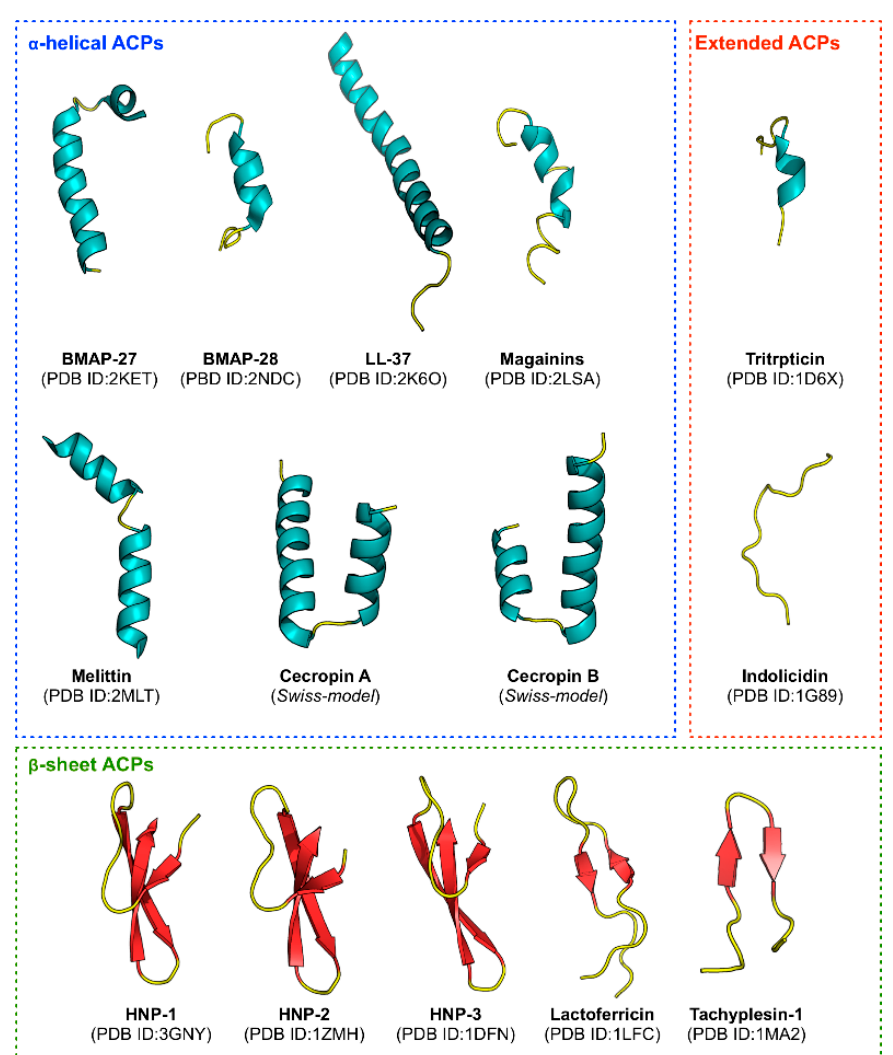
Figure 1. Overview of the structural diversity of three classes of anticancer peptides. Each structure is labeled by its common name followed by the Protein Data Bank (PDB ID) in parenthesis on the subsequent line. In cases where the PDB ID was not available, the SWISS-MODEL server (available at: https://swissmodel.expasy.org/) was used to construct the structure.